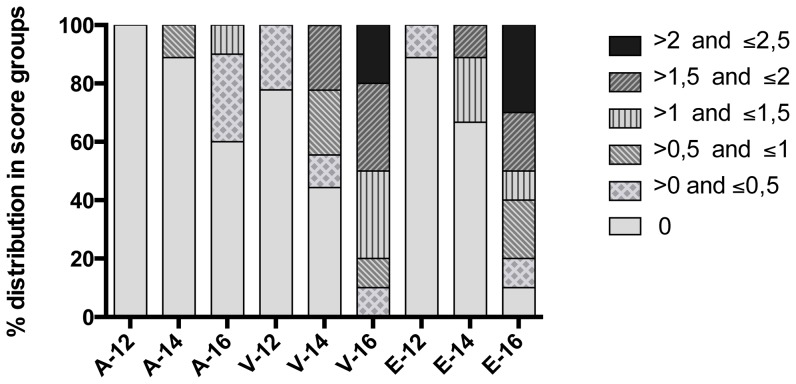
Histoscores in heart at 12, 14 and 16 weeks following experimental challenge of Atlantic salmon.Different organ compartments (atrium (A), ventricle (V) and epicard (E)) have been grouped according to score intensity at the different time points and are separated in score groups as indicated. 0) No pathological changes observed. 1) Mild pathological changes; limited (countable) mononuclear inflammatory cells infiltrating the epicardium. Multifocal to diffuse cell infiltration, can involve parts of/entire epicardium. 2) Moderate pathological changes; high number (uncountable) of inflammatory cells in the epicardium, extending into the compact layer of the heart. In compact layer, multifocal or diffuse changes typically oriented along small blood vessels. A few focal changes in the spongious layer. 3) Severe pathological changes; intense infiltration of inflammatory cells in the epicardium and compact layer, typically with a diffuse distribution pattern, and involving the spongious layer in a multifocal pattern. Degeneration/necrosis of muscle fibers. Inflammatory changes comparable to ventricle can be seen in atrium.